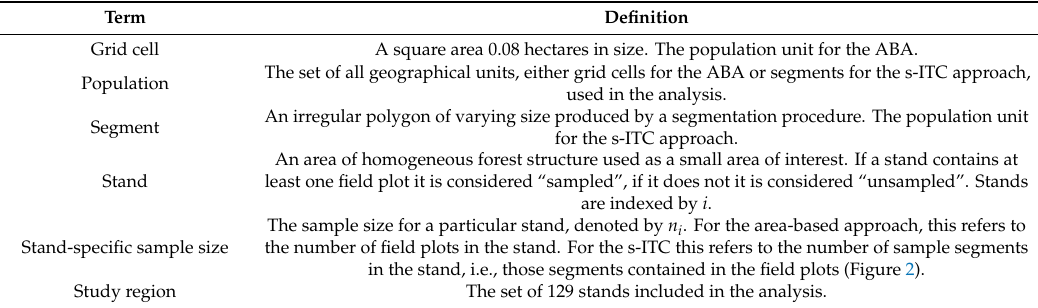
Figure 2. Canopy height model (blue to green background) displayed underneath delineated segments (black lines) and grid cells (white lines). Two example field plots are shown (red circles) with included segments shaded in orange. The green line in the center represents a stand delineation. Table 2. Glossary of frequently used terms in this